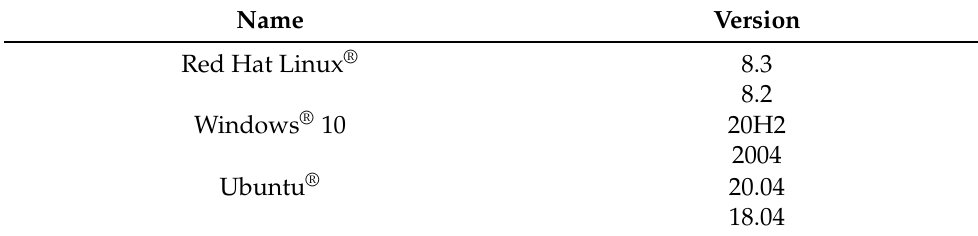
Table 4. Operating Systems Tested.